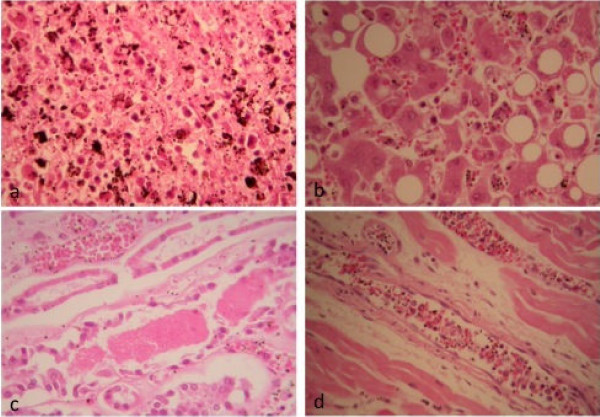
Haematoxylin and eosin stained extra cerebral tissues. (5a) spleen × 400 showing red pulp macrophages containing much haemozoin pigment as well as phagocytozed red blood cells. (5b) liver × 400 showing macrovesicular steatosis of hepatocytes without parenchymal inflammation. The sinusoids have abundant parasitized red blood cells as well as Kupffer cells containing haemozoin. (5c) kidney × 200 showing acute tubular necrosis and intratubular casts. Intravascular parasitized red blood cells also visible. The myofibres of the left ventricle of the heart are normal (5d × 200). Small veins and capillaries contain abundant parasitized red blood cells and endothelial cells are prominent.